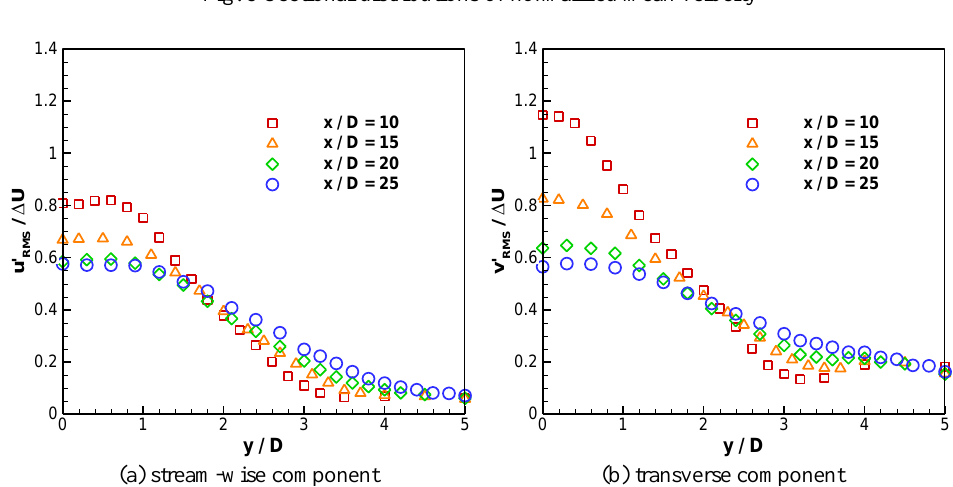
Fig. 3 Sectional distributions of normalized mean velocity